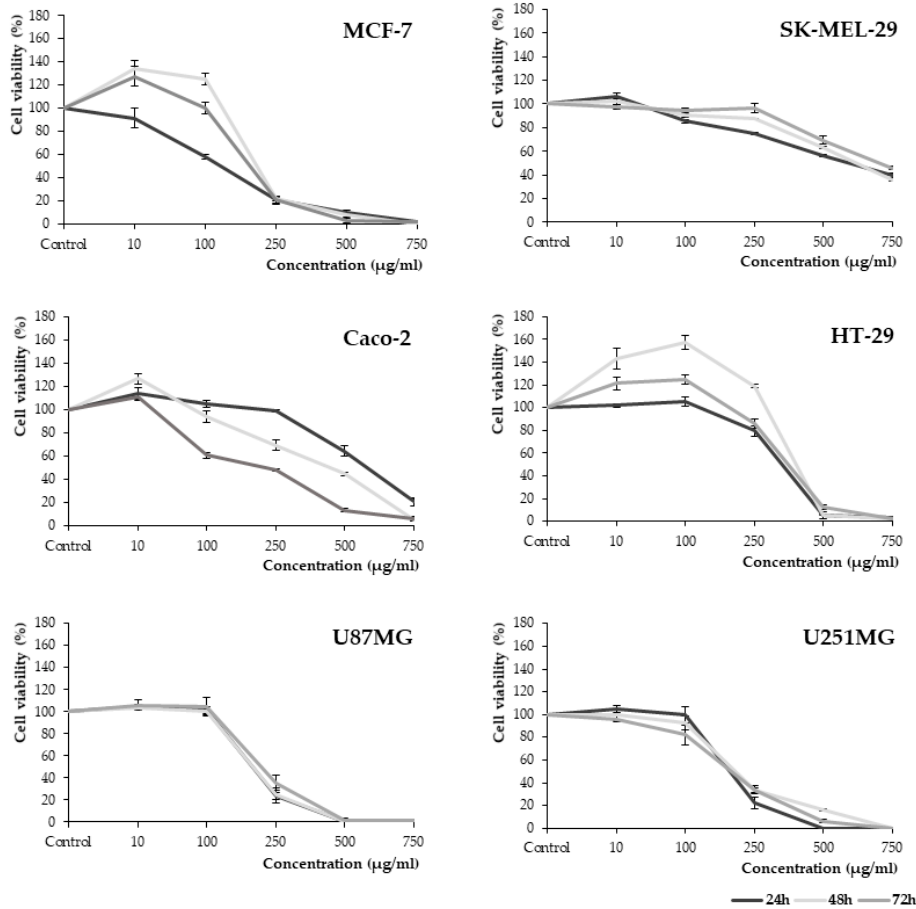
Figure 1. Cytotoxic effect of different concentrations (10–750 µg/mL) of J. regia flower extracts on breast adenocarcinoma (MCF-7), melanoma (SK-Mel-29), colorectal adenocarcinoma (Caco-2; HT-29), glioblastoma (U87MG), and astrocytoma cell lines (U251MG). All cells were treated for 24, 48, and 72 h. The number of viable control (non-treated) cells at each time point served as 100%. Graphs represent mean values ± SD from three independent experiments.